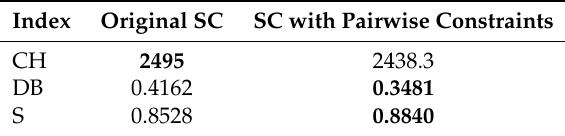
Table 2. Internal validation measures for spectral